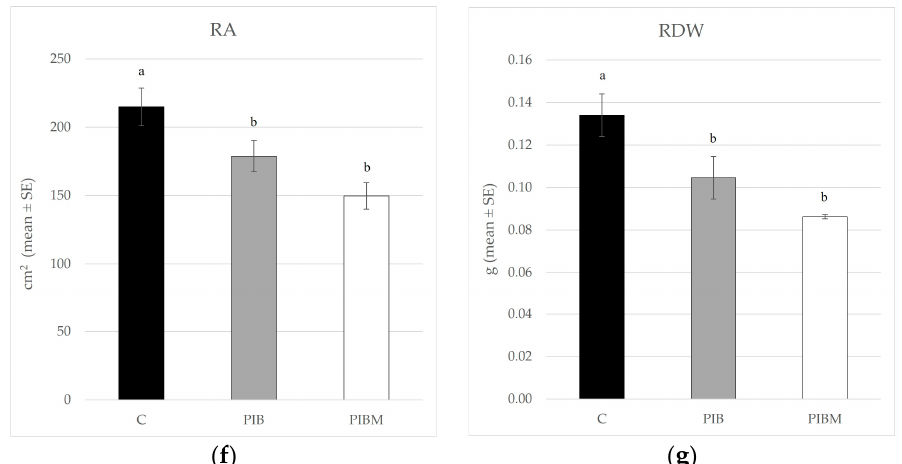
Figure 3. Mean values (±SE) of ( a ) plant height (PH), ( b ) indirect chlorophyll content (ICC), ( c ) chlorophyll fluorescence (CF), ( d ) leaf area (LA), ( e ) shoot dry weight (SDW), ( f ) root area (RA), and ( g ) root dry weight (RDW) of noninfested control plants (C), host plants infested by B. tabaci (PIB), and eggplants in the presence of both whitefly and M. pygmaeus (PIBM). Different letters indicate statistically significant differences at p < 0.01.